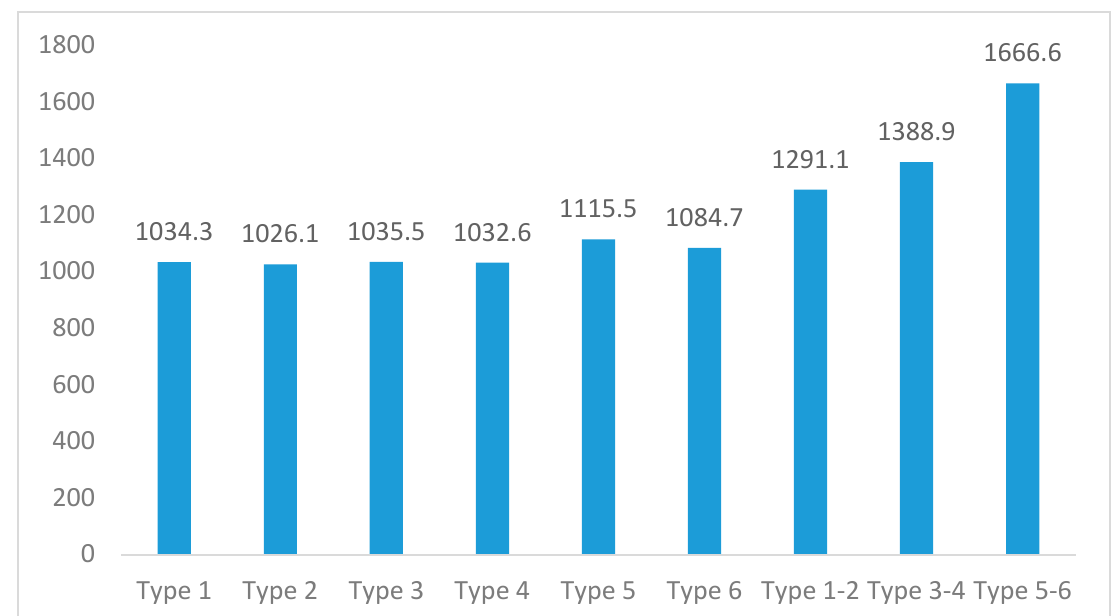
Figure 10. Total energy consumption of designed building types.